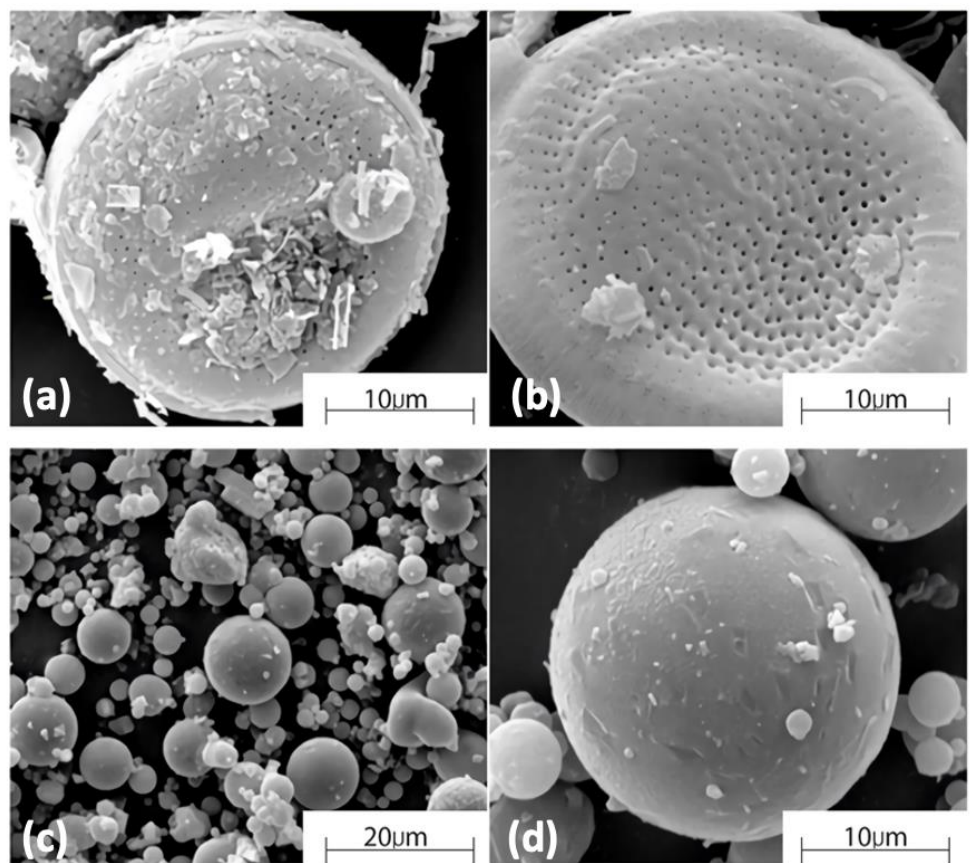
Figure 7. SEM micrographs of diatomite/paraffin composite: ( a ) diatomite in as-received condition, ( b ) diatomite after the calcination process, ( c ) composite structure of paraffin/diatomite and ( d ) higher magnification view of single composite sphere [76].